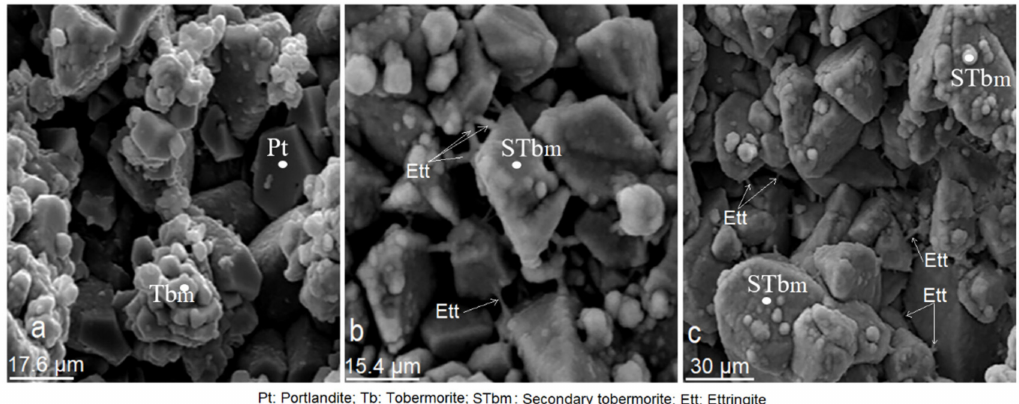
Figure 17. ( a – c ). Microphotographs of cement/mordenite specimens (CMS) taken after 365